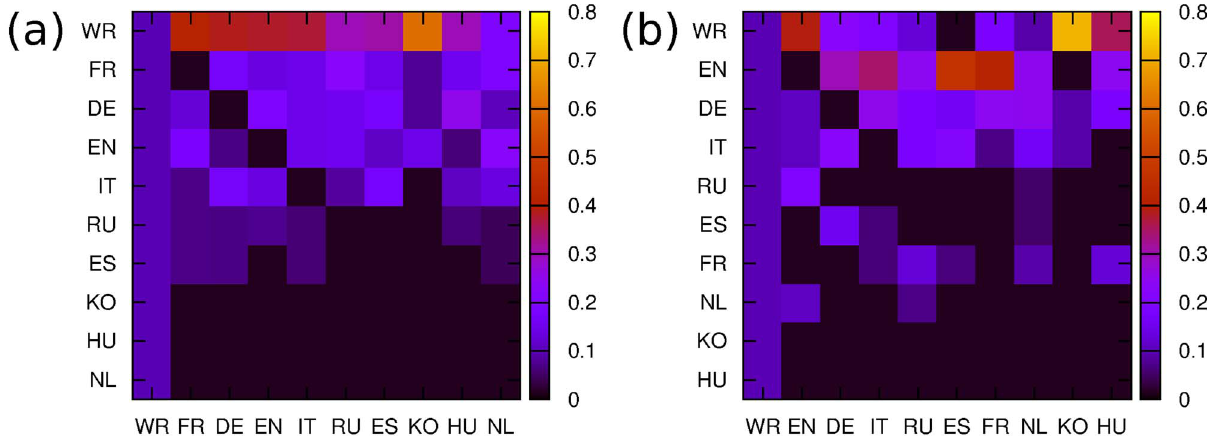
Figure 6. Google matrix of network of cultures from Fig. 5, shown respectively for panels ( a ),( b ) . The matrix elements G ij are shown by color at the damping factor a ~ 0 : 85 , index j is chosen as the PageRank index K of PageRank vector so that the top cultures with K ~ K ’ ~ 1 are located at the top left corner of the matrix.